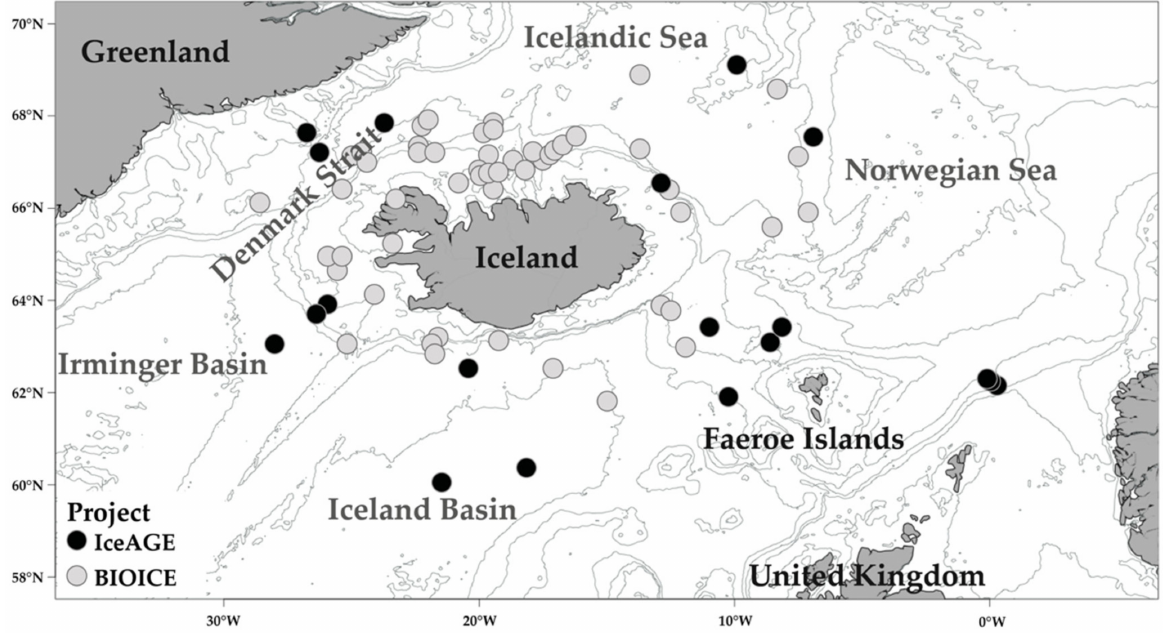
Figure 1. Sampling locations of the E. producta complex. Black dots indicate E. producta complex sampling locations during the IceAGE1 and IceAGE2 cruises used in the current study; grey dots indicate E. producta complex sampling locations during the BIOICE project. Note: Due to the formalin fixation of BIOICE samples, no genetic data are available. The figure was reprinted and adapted from [28] by permission from Springer Nature, Marine Biodiversity